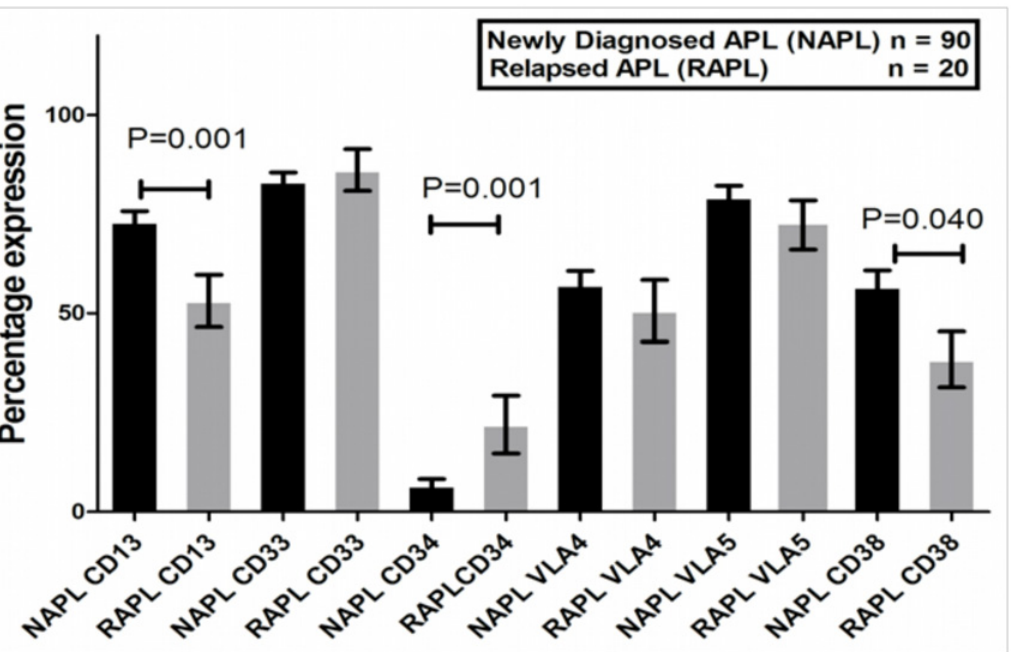
Fig 1. Comparison of bone marrow blast immunophenotypic surface marker expression percentage between newly diagnosed and relapsed patients. The percentage expression of common APL surface markers like CD13, CD33, CD34, CD38, VLA4 and VLA5 are illustrated as grouped bar graphs for newly diagnosed (black bars) and at relapse (grey bars). The mean ± SEM were significantly different for CD13, CD34 and CD38 between the newly diagnosed and relapsed patients.